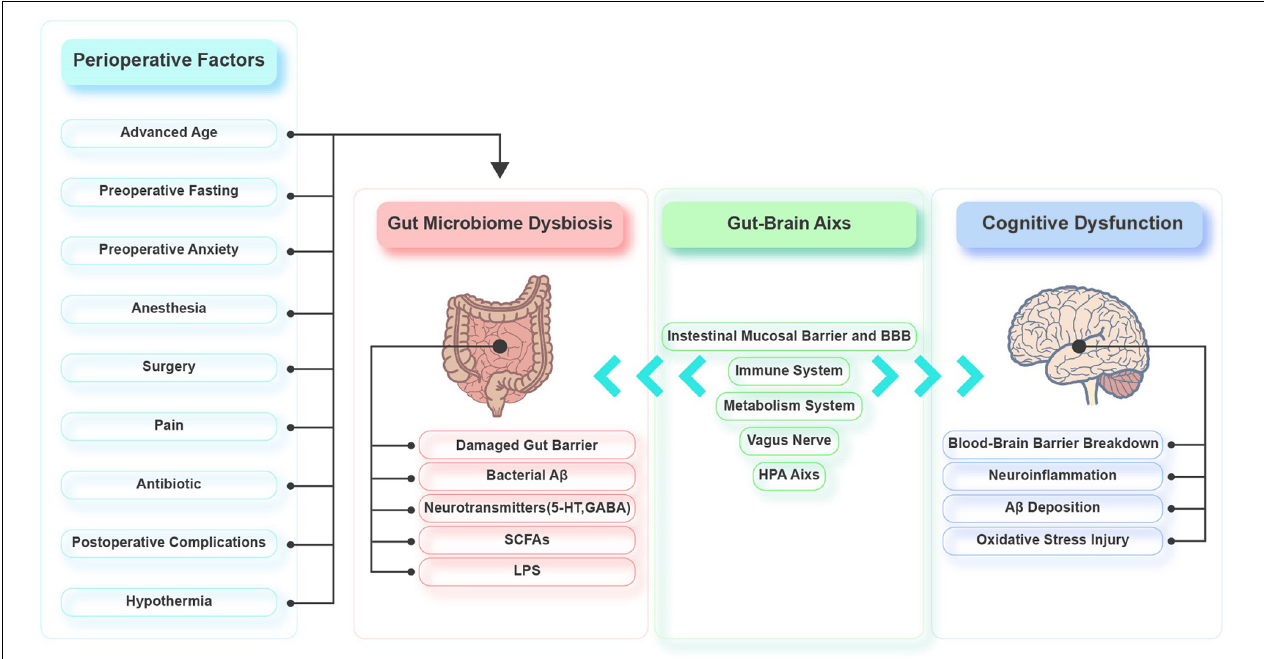
FIGURE 2 | Possible role of gut microbiota in perioperative neurocognitive disorders